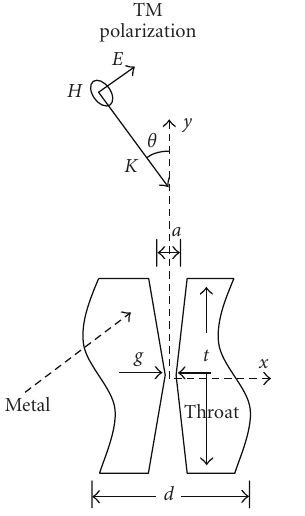
Figure 1: Schematic view of the lamellar transmission metallic grat- ing with converging-diverging channels in vacuum with grating pa- rameters as period ( d ), aperture ( a ), and thickness ( t